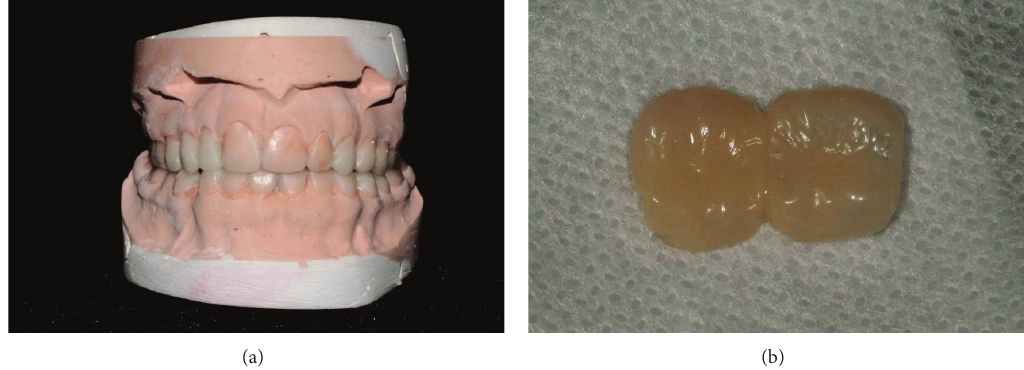
Figure 3: (a) Anterior diagnostic waxup. (b) Posterior resin crowns made according to the waxup.